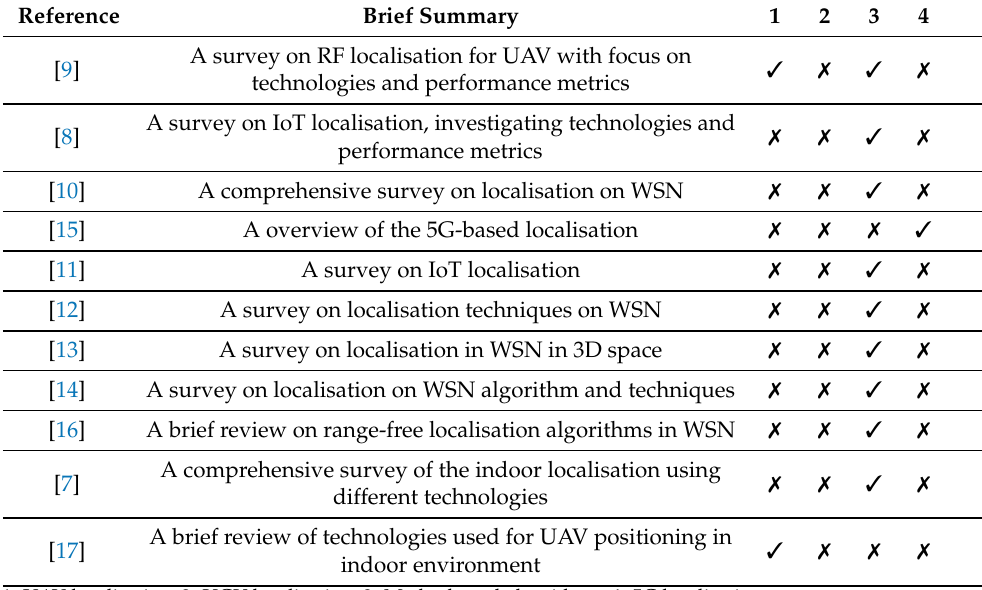
Table 1. Comparison between existing